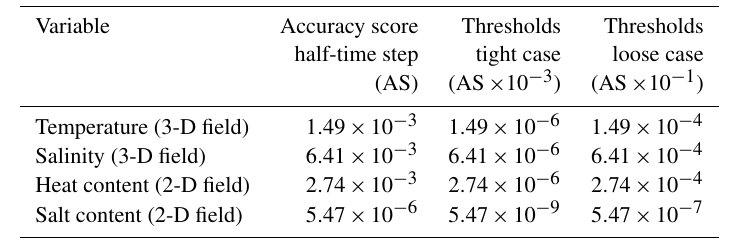
Table 1. Accuracy score of the simulation performed using a time step shorter than the reference and the different thresholds used for the different variables in the tight and loose cases. The thresholds for the tight case are defined by multiplying the accuracy score of the half- time-step simulations by 10 − 3 , and the thresholds for the loose case are defined by multiplying the accuracy score of the half-time step by 10 − 1 .